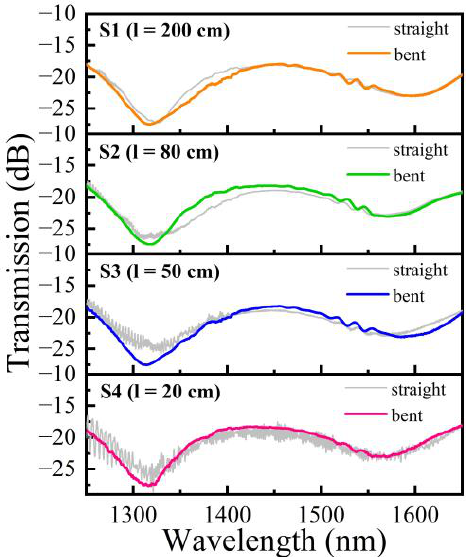
Figure 4. Schematic diagram of the experimental setup for measuring the transmission spectra of the cascaded MZI samples. (ASE: amplified spontaneous emission, OSA: optical spectrum analyzer, inset: schematic diagram of the cascaded MZI samples).